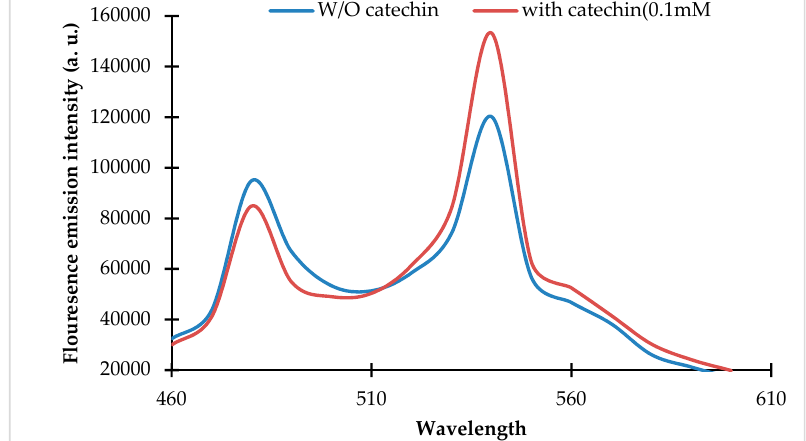
Figure 1. Spectral analysis of the purified protein of the fluorescence indicator protein for ( + )-catechin (FLIP-Cat) nanosensor. Fluorescence emission intensity (460 nm to 610 nm) was recorded by the addition of (+)-catechin (0.1 mM) and without (+)-catechin (0 mM). Excitation of FLIP-Cat was carried out at 430 nm.